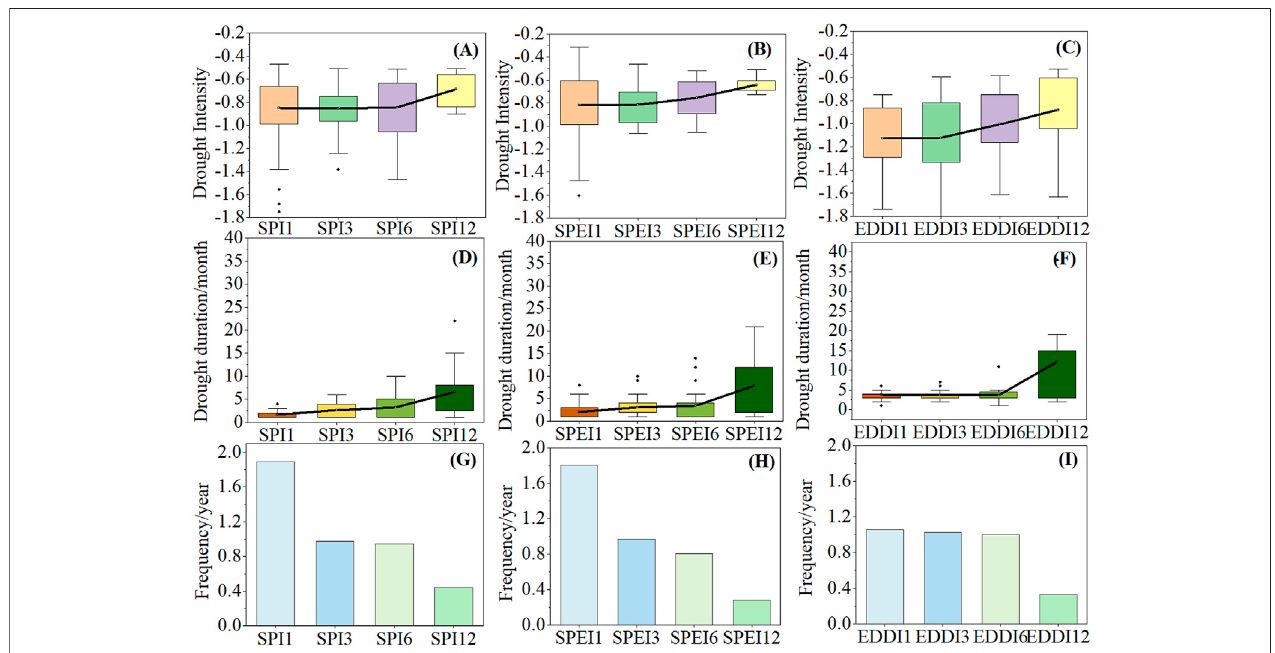
FIGURE 3 | Drought intensity (A – C) , duration ( D – F) , and frequency (G – I) of the SPEI, EDDI, and SPI at 1-, 3-, 6-, and 12-month timescales in the LRB between 1981 and 2016 (it is noted that the black horizontalline represents the average value of drought characteristics at different scales; black dots mean outliers; the range of boxes represents the 75% quantile and the 25% quantile; and the whiskers mean the 75% quantile and 25% quantile of 1.5 times,